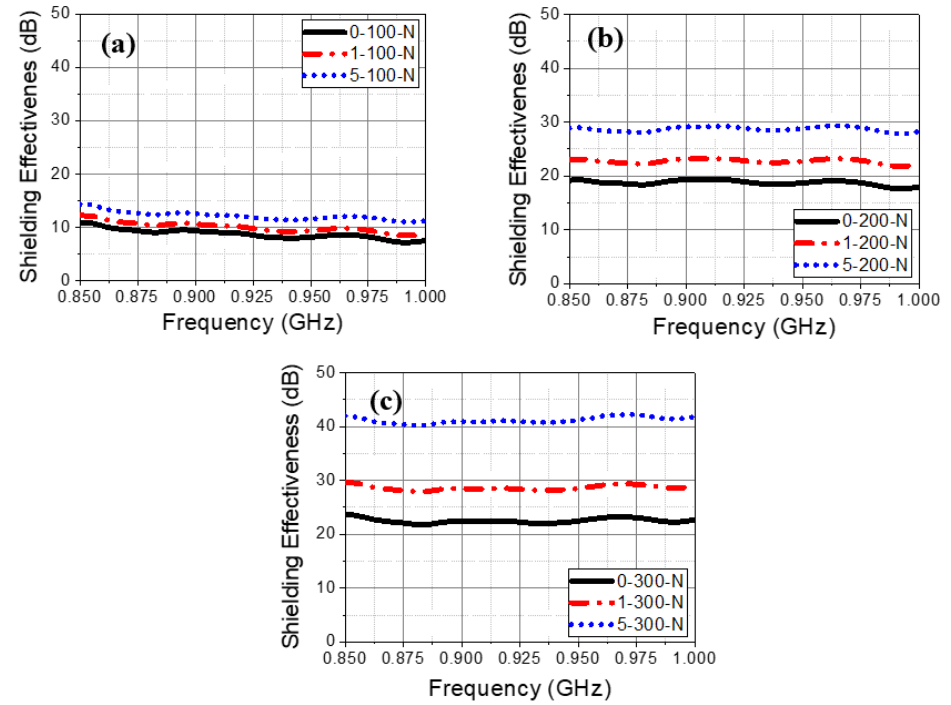
Figure 6. Shielding effectiveness vs. studied frequencies plots without using Zn – Al coating for ( a ) 100 ( b ) 200, and ( c ) 300 mm concrete thickness with 1 and 5 wt% carbon black.